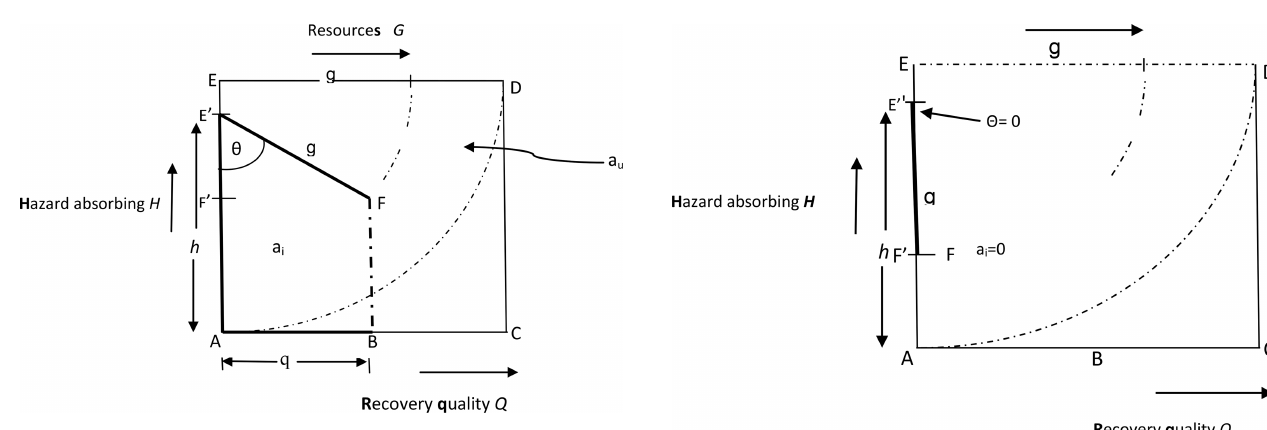
Figure 3. Resilience conceptual model. A geometric model used to derive appropriate mathematical relationships of the proposed framework and provide some insights.